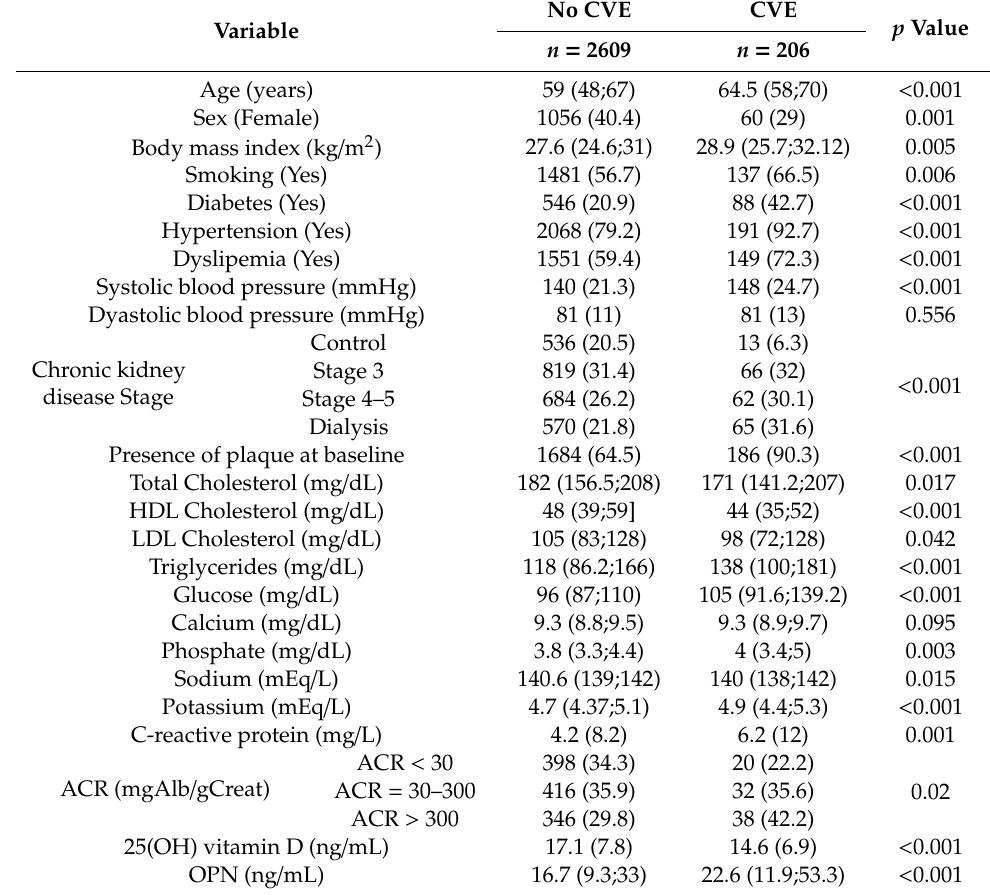
Table 1. Epidemiological, clinical, and biochemical parameters of patients according to the presence or absence of cardiovascular events.